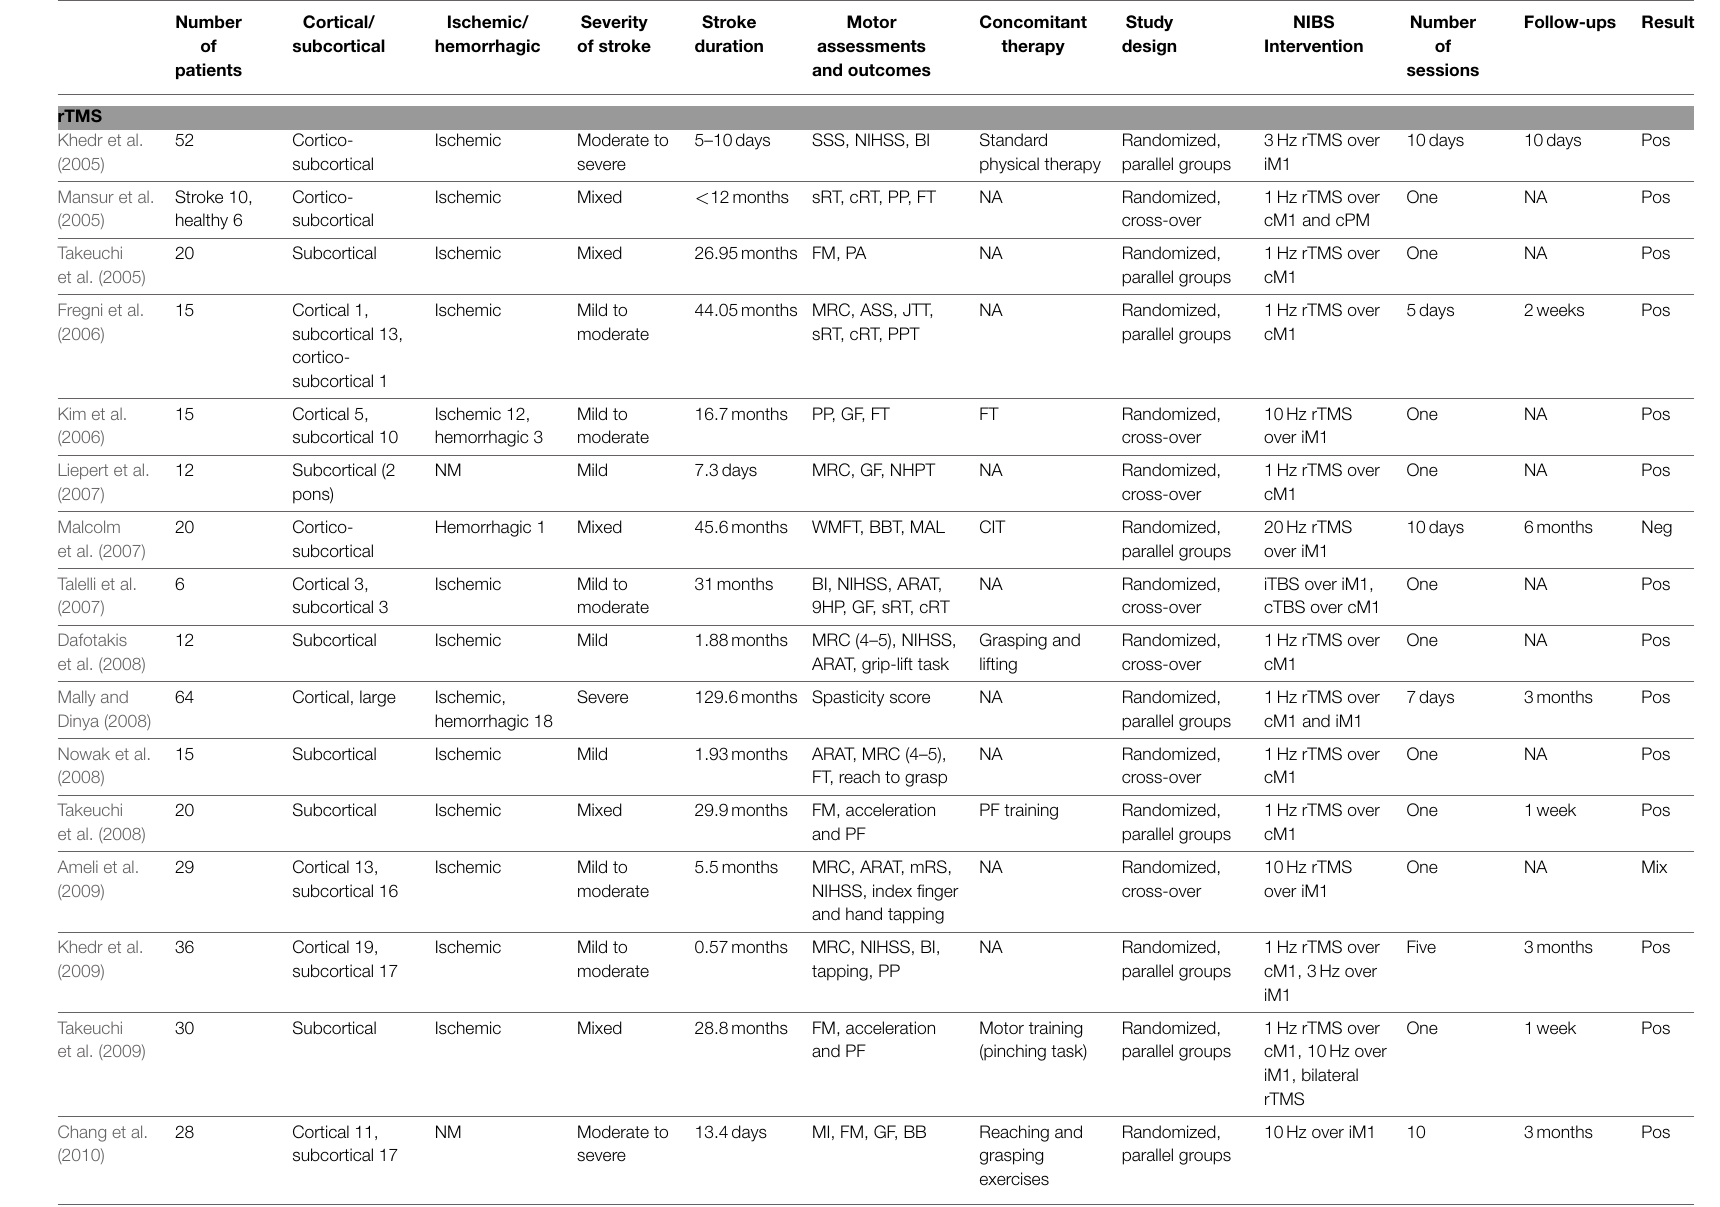
TABLE 1 | Summary of the sham-controlled studies performed with non-invasive brain stimulation in motor recovery after stroke